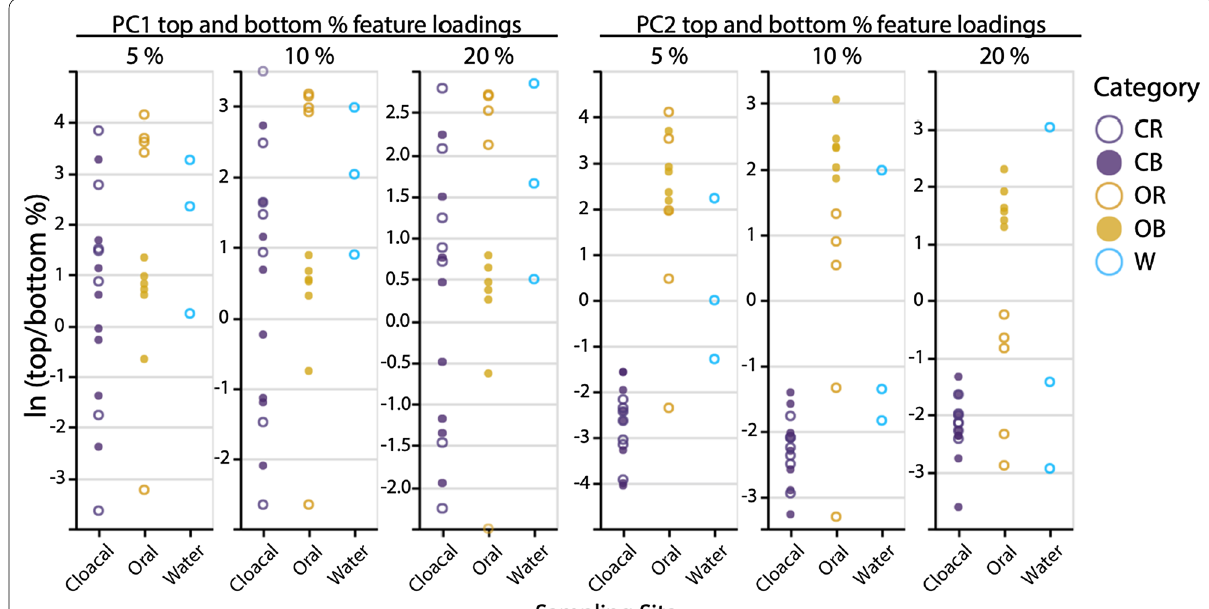
Fig. 4 Natural log-ratios (plotted by QURRO) of loggerhead samples’ top and bottom 5%, 10%, and 20% of feature loadings on rPC1 and rPC2 of Robust Aitchison PCA biplot feature loadings by sampling site and period: CB, cloacal before; CR, cloacal rehabilitated; OB, oral before; OR, oral rehabilitated; W, tank